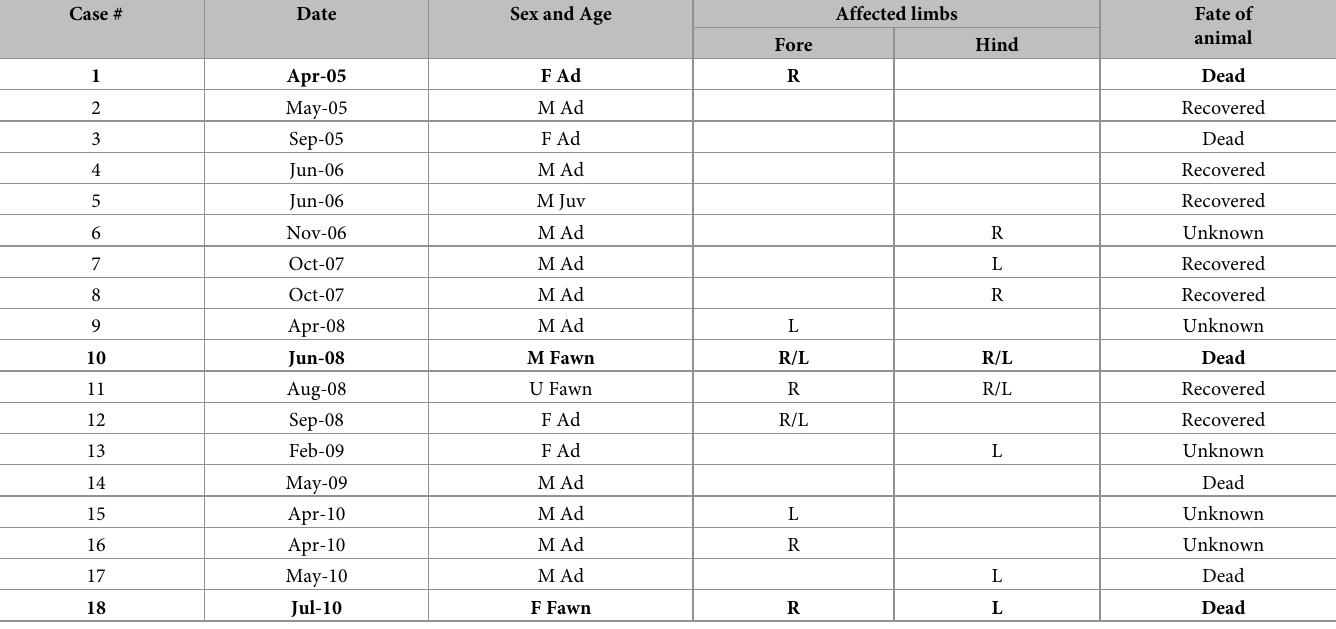
Table 2. Huemul deer with foot lesions in Huemules Valley.